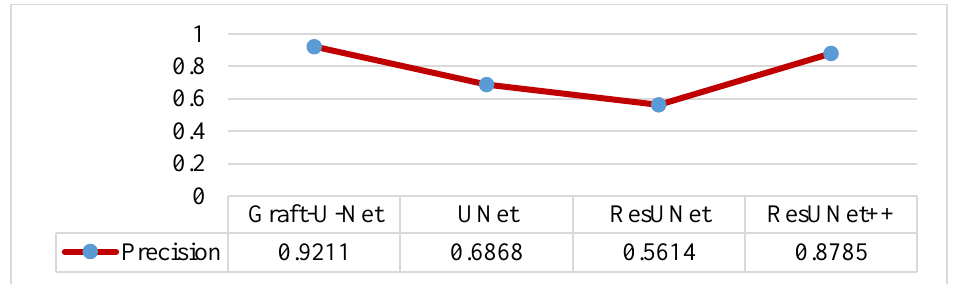
Figure 15. Comparison of Graft-U-Net on CVC-ClinicDB Dataset in terms of precision.